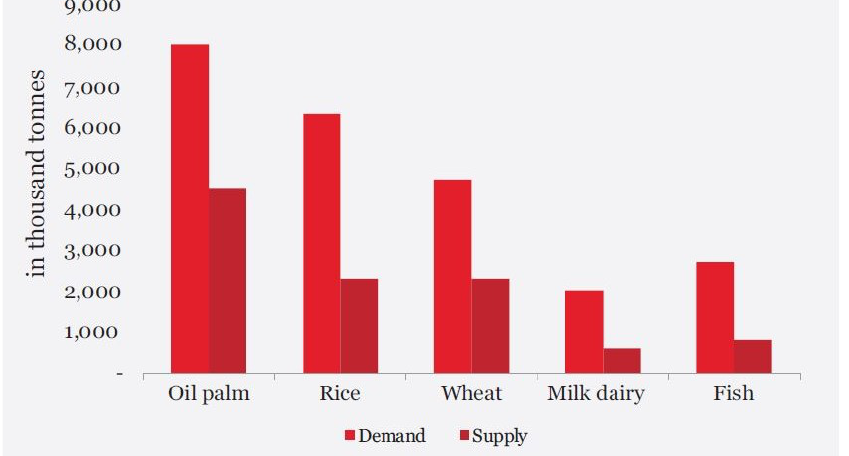
Figure 1. Nigeria's demand and supply gap for key agricultural products (2016) [1].